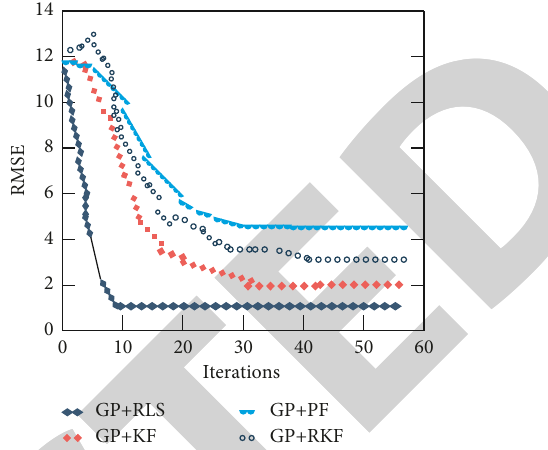
Figure 2: Convergence of parameter estimation errors of the E- CELL model under Gaussian noise.